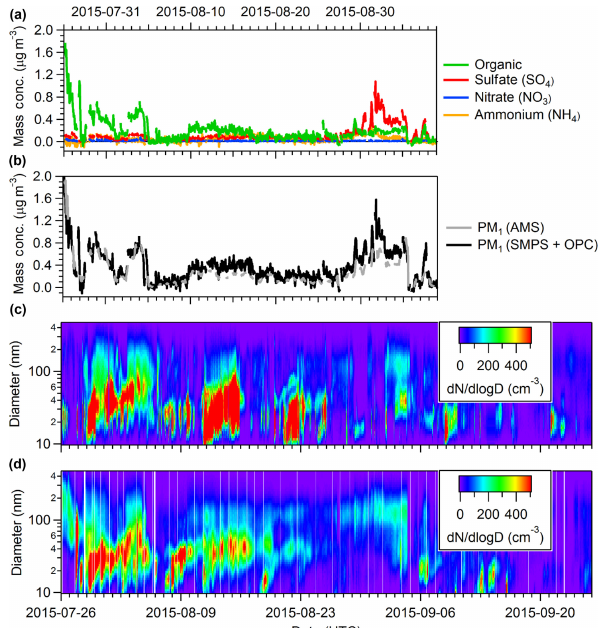
Figure 4. Box and whisker plots of hourly particle number concen- trations for diameters between (a) 10 and 487nm and (b) 10 and 100nm measured from 27 July to 9 September 2015 and 2016 in Alert and at the PEARL RidgeLab near Eureka. The plots indicate the 10th, 25th, 50th, 75th and 90th